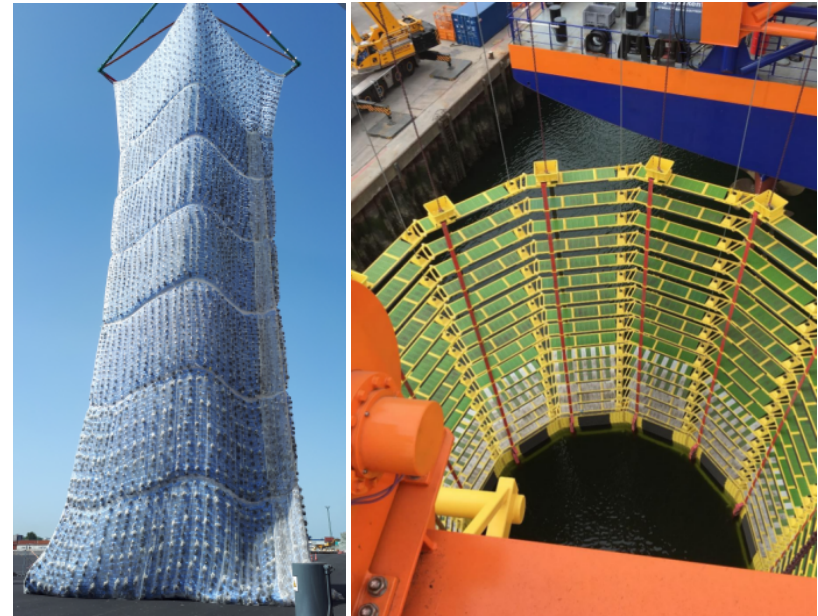
Figure 16. ( Left ) The HSD system with a length of 40 m hanging from the crane. Source: c (cid:13) OffNoise-HSD-Systems GmbH (https://www.offnoise-solutions.com/the-hydro-sound-damper- system-hsd-system/). ( Right ) The newly developed AdBm-NAS system showing the resonators in the array. c (cid:13) AdBm Technologies